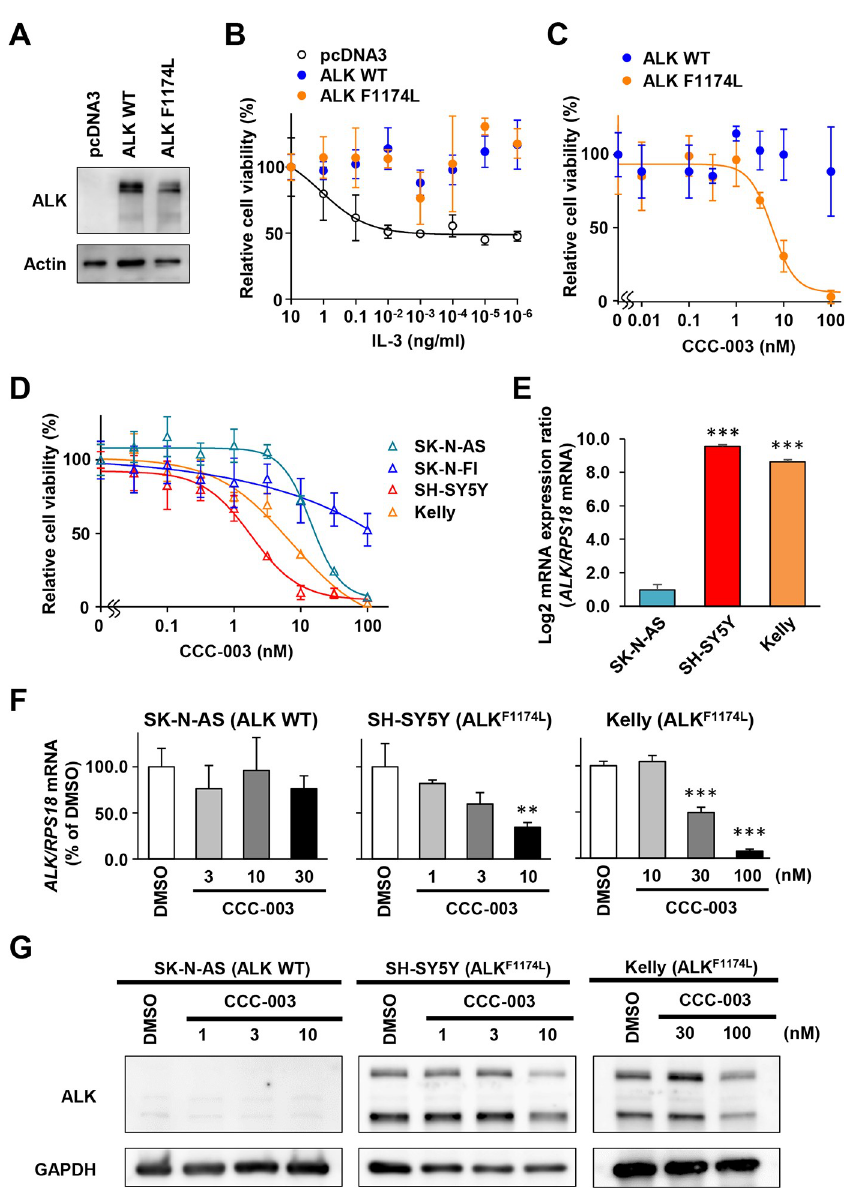
Fig 2. CCC-003 inhibits ALK expression in ALK -mutated neuroblastoma cell lines. (A) Western blotting analysis confirmed the expressions of wild-type (WT) and F1174L-mutated ALK in Ba/F3 cells after G418 selection. (B) WST assay in ALK-expressing Ba/F3 cells. The cells were cultured with the indicated concentrations of IL-3 for 72 h. (C) Ba/ F3 cells expressing ALK were treated with 0.01–100 nM CCC-003 in the absence of IL-3 for 72 h and subjected to WST assay. (D) WST assay in neuroblastoma cells. SK-N-AS, SK-N-FI, SH-SY5Y, and Kelly cells were incubated with the indicated concentrations of CCC-003. 72 h after treatment, the percentage of viable cells was determined and depicted using GraphPad Prism. Error bars indicate the SD of data from triplicate experiments. (E) ALK wild-type SK-N-AS and ALK F1174L-mutated SH-SY5Y and Kelly cells were treated with DMSO for 24 h. ALK mRNA expression was analyzed using qRT-PCR. RPS18 was used as an internal control. P -values were determined using one-way ANOVA followed by a Bonferroni post-hoc test ( ��� , P < 0.001). Data are presented as the mean ± SD from three independent experiments. (F) SK-N-AS, SH-SY5Y, and Kelly cells were treated with 3–30, 1–10, or 10–100 nM CCC-003 for 24 h, respectively. ALK mRNA expression was analyzed using qRT-PCR. DMSO was used as a control treatment. RPS18 expression was used as a housekeeping gene. P -values were determined using one-way ANOVA followed by a Bonferroni post-hoc test ( �� , P < 0.01; ��� , P < 0.001). Data are presented as the mean ± SD from three independent experiments. (G) SK-N-AS and SH-SY5Y cells were treated with 1–10 nM CCC-003, and Kelly cells were treated with 30–100 nM CCC-003 for 48 h. ALK protein levels were analyzed using western